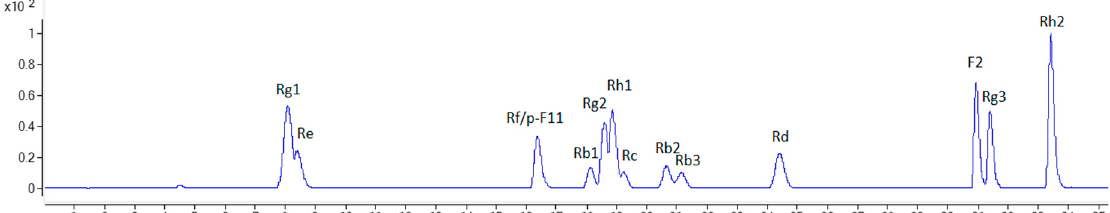
Figure 2. The base peak chromatogram (BPC) of 14 ginsenoside reference standards.